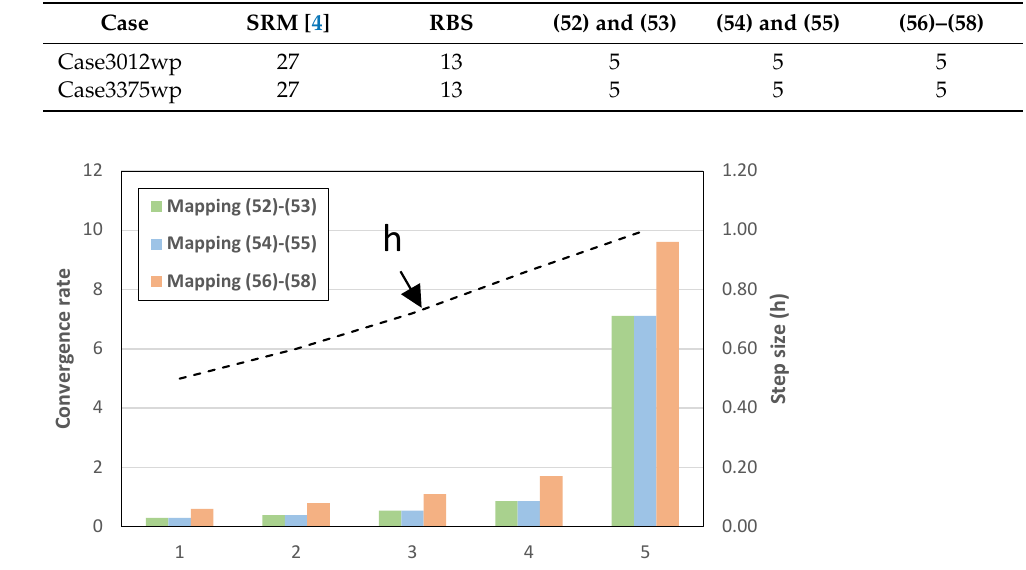
Figure 2. Convergence rates of 4OJ and the developed methods for the ‘case9241pegase’ .